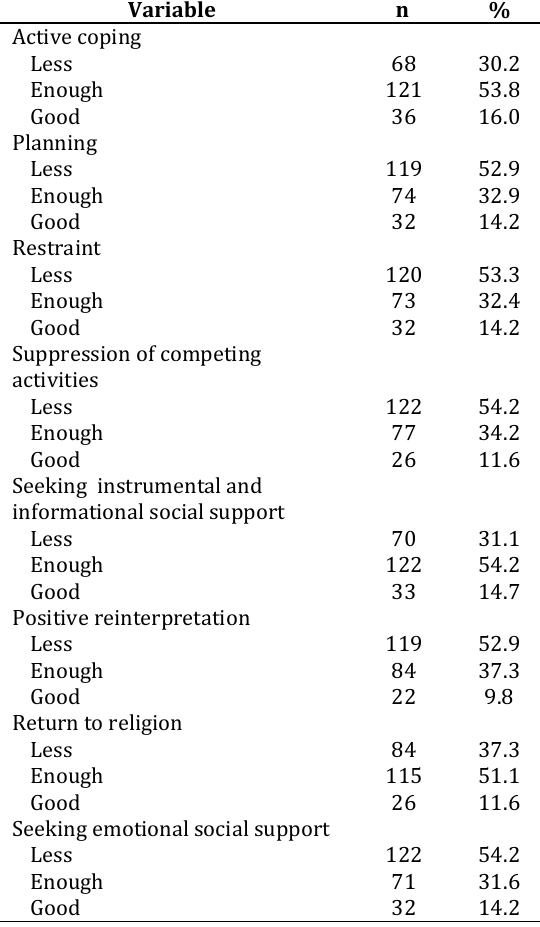
Table 2. Frequency Distribution of